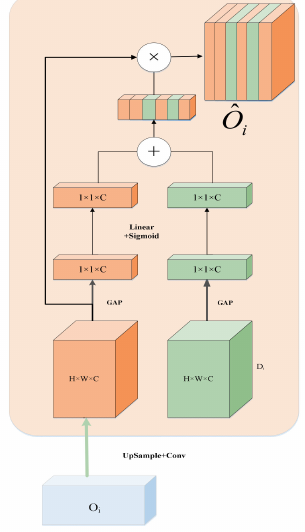
Figure 5. Channel-wise Cross Attention